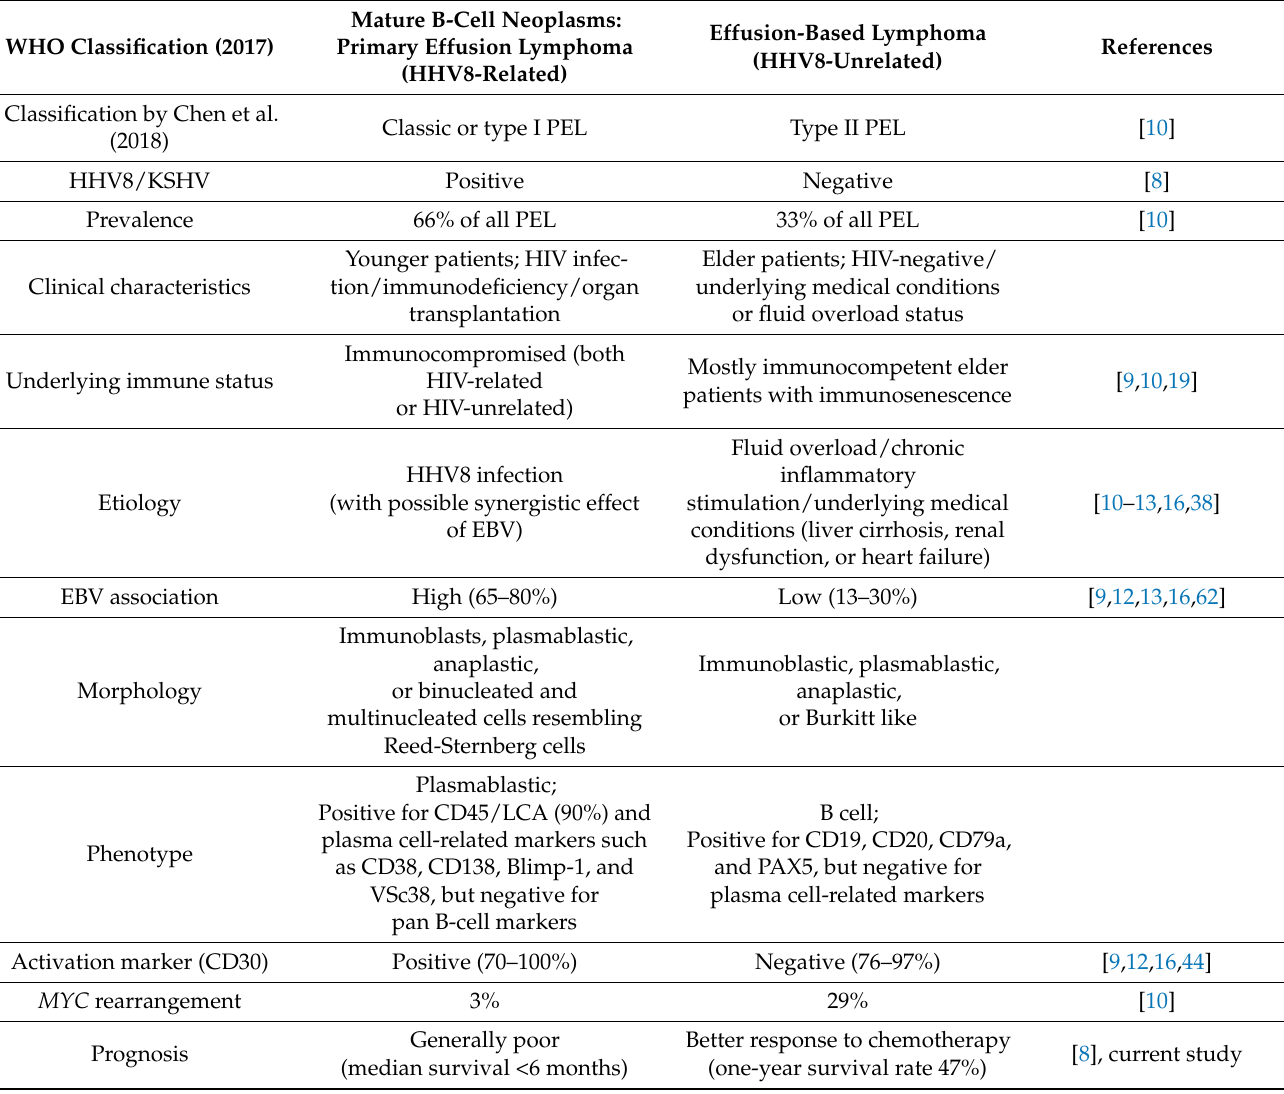
Table 2. Comparison of the pertinent clinicopathological features of HHV8-related (classical or type I) and HHV8-unrelated (type II)